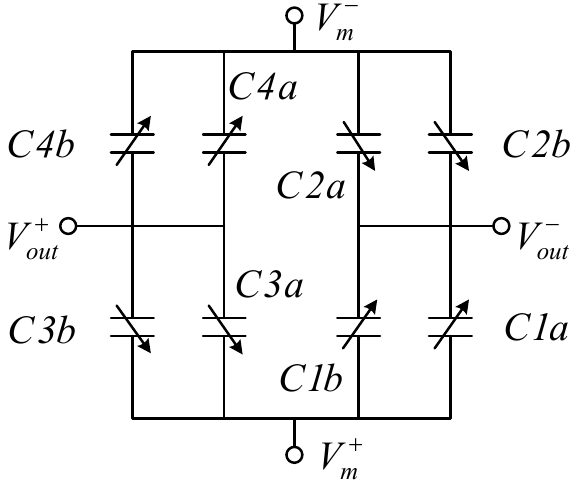
Figure 4. Electrical equivalent circuit for the common-centroid configuration of the sensing capacitors.